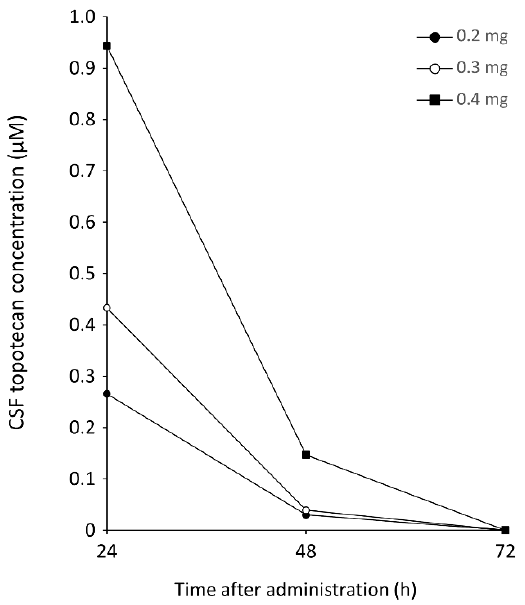
Figure 6. Clinical monitoring of topotecan using the developed HPLC method. The ventricular CSF concentration–time curves of total topotecan, following an intraventricular dose of 0.2, 0.3, or 0.4 mg.